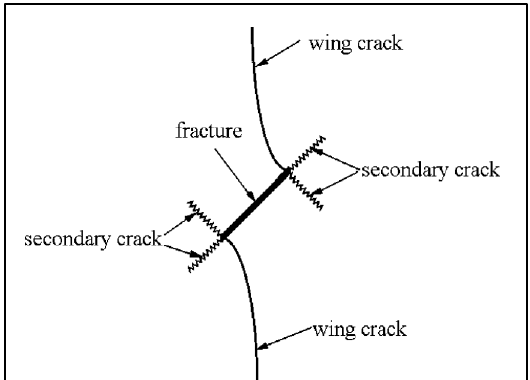
Figure 1. A simplified crack pattern in pre-cracked specimens of rock materials [3].